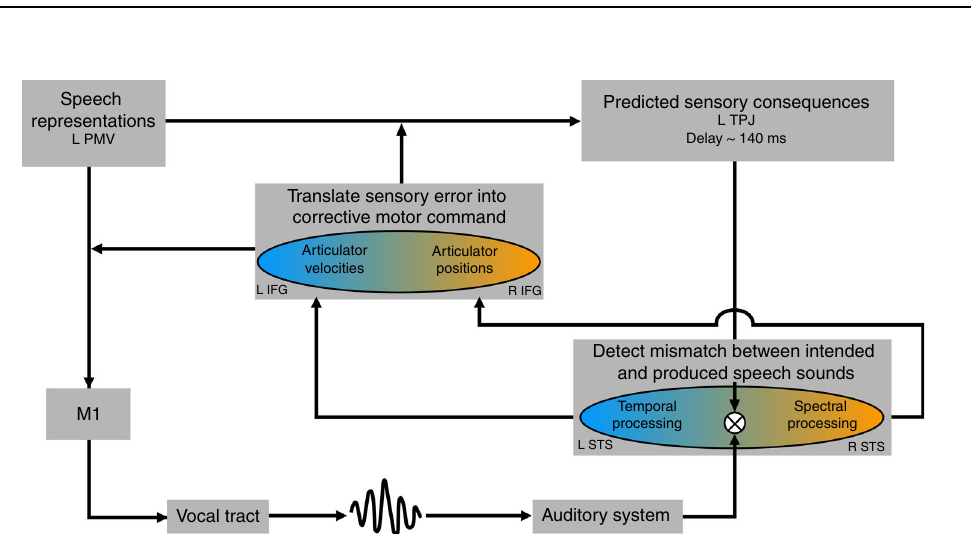
Fig. 5 Revised auditory feedback control loop of the DIVA model. The speci fi ed model includes two parallel auditory feedback control subsystems that preferentially monitor and correct temporal (blue) or spectral (orange) properties of the produced speech sound. Projections from the left premotor